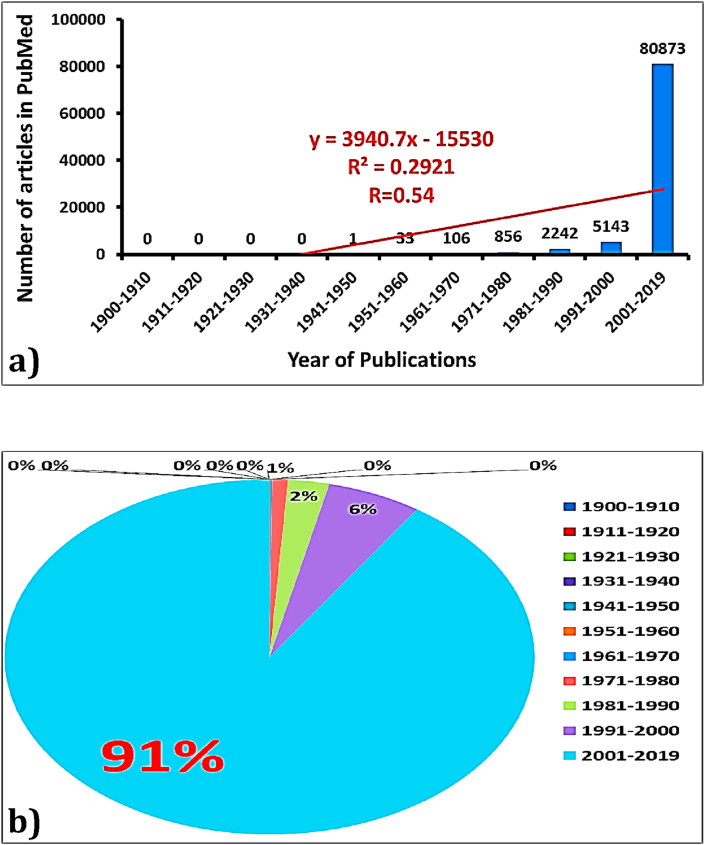
Articles published on interdisciplinary in PubMed. a. Number of articles published in PubMed on “interdisciplinary” from the year 1990–2019. b. Percentage of the article published PubMed on “interdisciplinary” from the year 1990–2019 (data source PubMed, accessed as on 11.08.2019 supplementary figure 1).